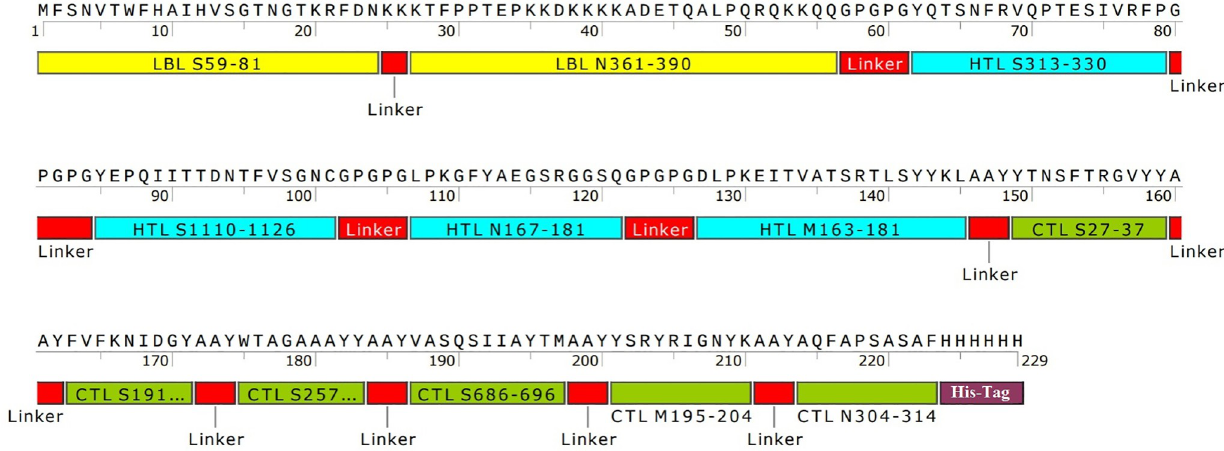
Fig 1. The designed multiepitope peptide construct: The schematic diagram of the construct contains LBL epitopes derived from the S and N proteins of the SARS-CoV-2 linked by KK linker, and HTL and CTL epitopes derived from the S, N and M proteins of the SARS-CoV-2 linked by GPGPG and AAY linkers, respectively. The designed construct starts with start Methionine codon and ends with His-tag. LBL: Linear B lymphocyte; HTL: Helper T-lymphocyte; CTL: Cytotoxic T-lymphocyte.